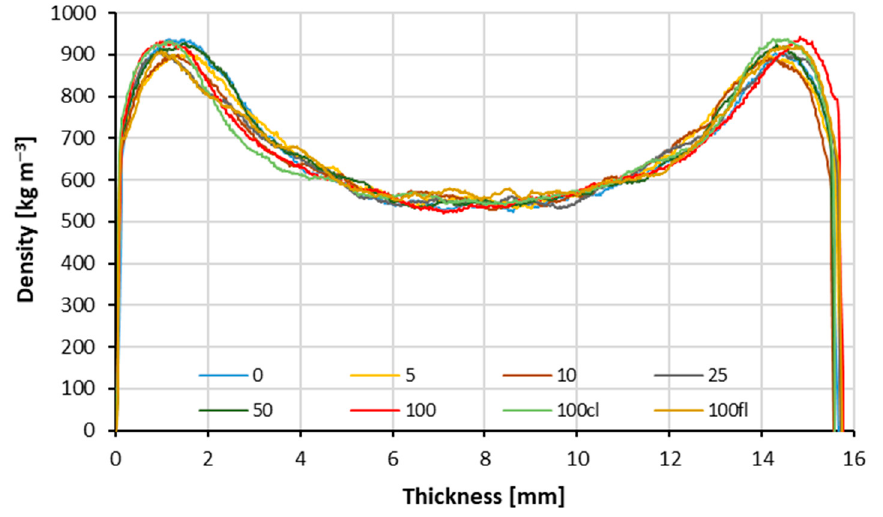
Figure 10. Density profiles of tested